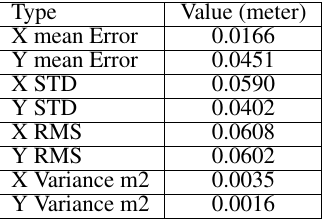
Table 2. Accuracy assessment of